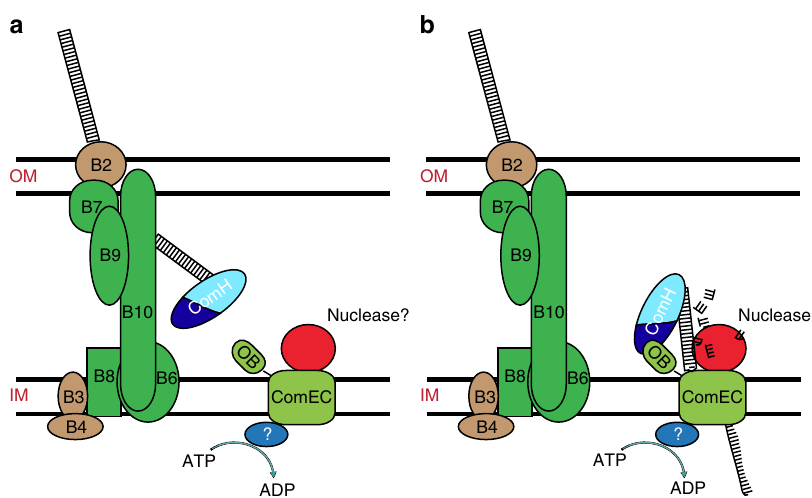
Fig. 7 Putative roles of ComH in the transport of tDNA through the bacterial envelope. a ComH binds to double-stranded DNA through its C-terminal domain (light blue) and allows the retention of the dsDNA into the cytoplasm as proposed for ComEA in V. cholerae 5 – 7 . b Through its N-terminal domain (dark blue) interaction with ComEC OB domain, ComH feeds the transforming DNA to the inner-membrane channel that mediates the translocation of the DNA into the cytoplasm as a